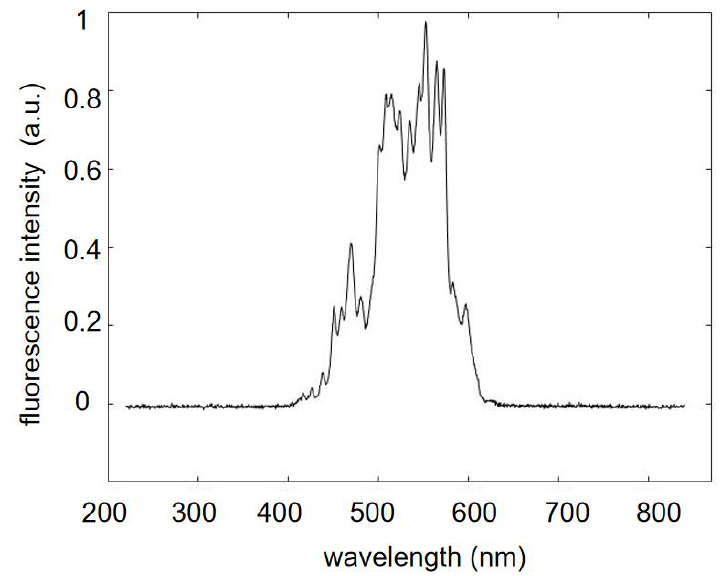
Figure 16. Photodarkening absorption spectrum of sample DCF.